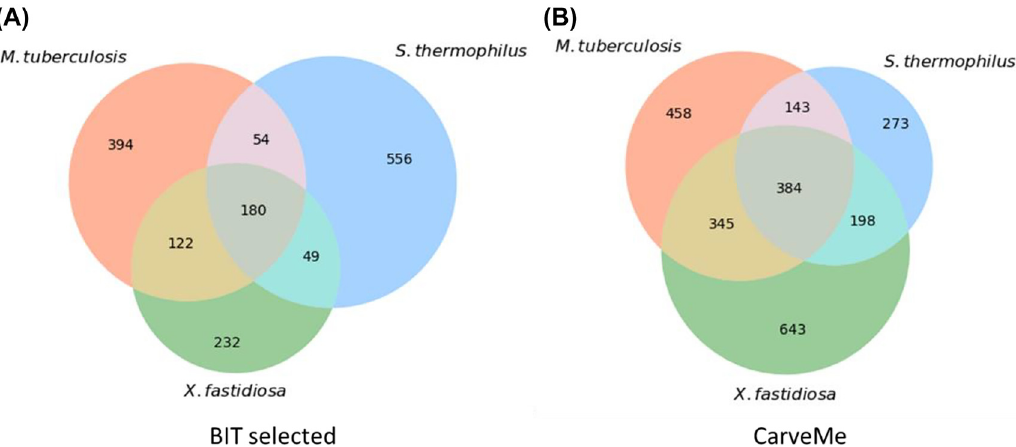
Figure 6: Venn diagrams of reactions from the draft models created with BIT’s selected template (A) and CarveMe (B), showing the number of reactions shared between the models of different organisms for the two approaches.